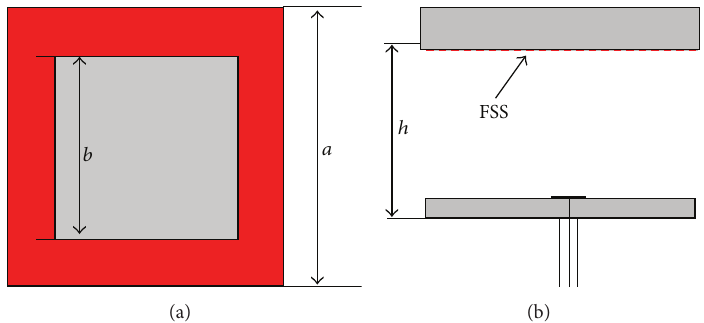
Figure 5: (a) Unit cell of the FSS and (b) patch antenna with FSS superstrate.